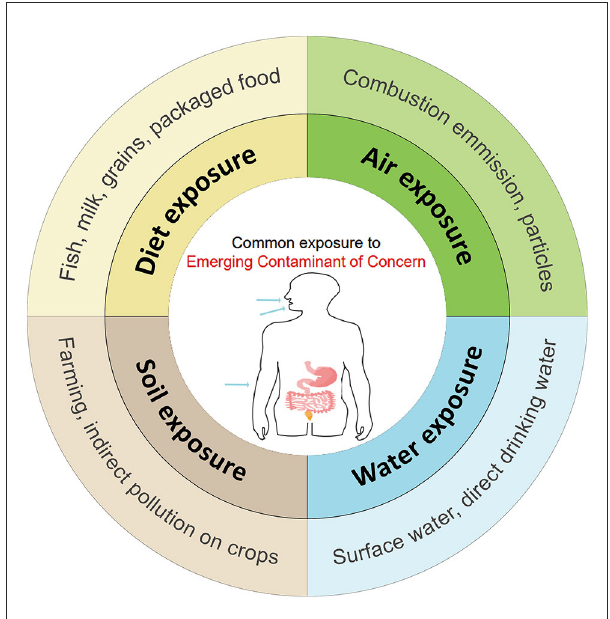
FIGURE1 The common way and pollutants that general population in exposure of Emerging Contaminants (ECs) through digestive tract, respiratory tract and skin